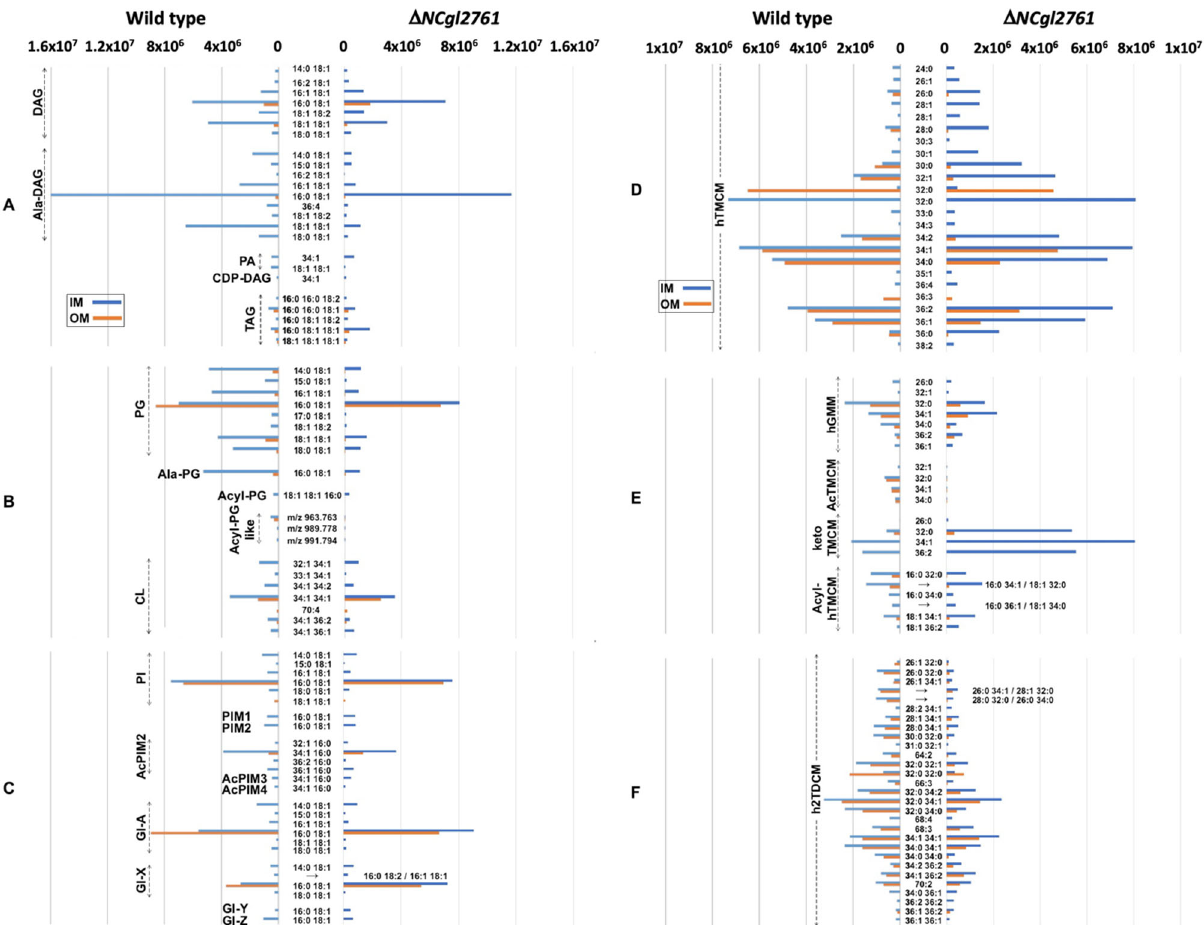
Figure 6. Comparison of the relative abundances of IM and OM lipids in C. glutamicum WT and a ∆ NCgl2761 mutant. The relative abundance of 144 species, identified by LC ‐ MS/MS profiling, in the IM and OM fractions. Lipid abundances (based on ion intensities) represent the mean value of four replicates. The relative abundance of DAG and TAG based lipid classes ( A ), PG and CL ‐ based lipid classes ( B ), PI/PIM and Gl glycolipid classes ( C ), hTMCM species ( D ), other trehalose and glucose corynomycolates ( E ) and h2TDCM species ( F ) are shown.